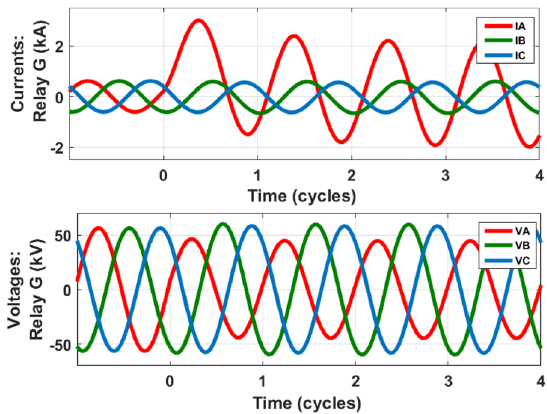
Fig. 11 Current and voltage waveforms recorded at terminal G. IA , IB and IC are the currents recorded in phases A, B and C respectively at terminal G. VA , VB and VC are the phase-ground voltages recorded in phases A, B and C respectively at terminal G